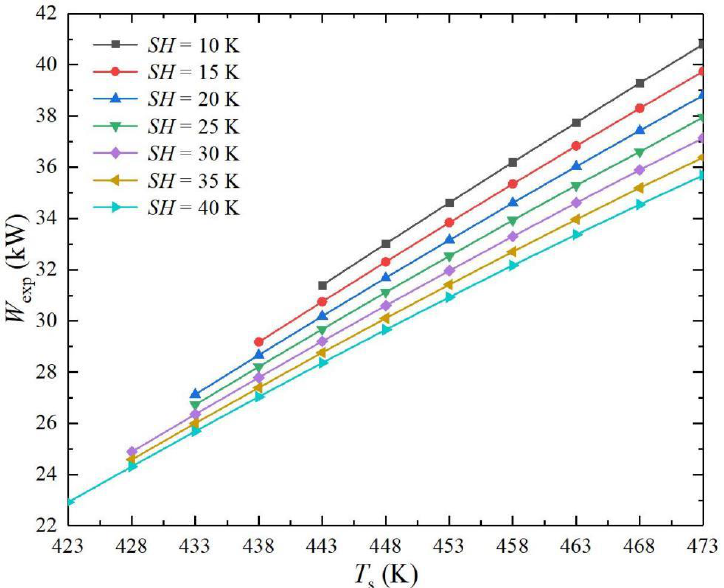
Figure 18. Power output of the expander with heat-source temperatures under different superheat